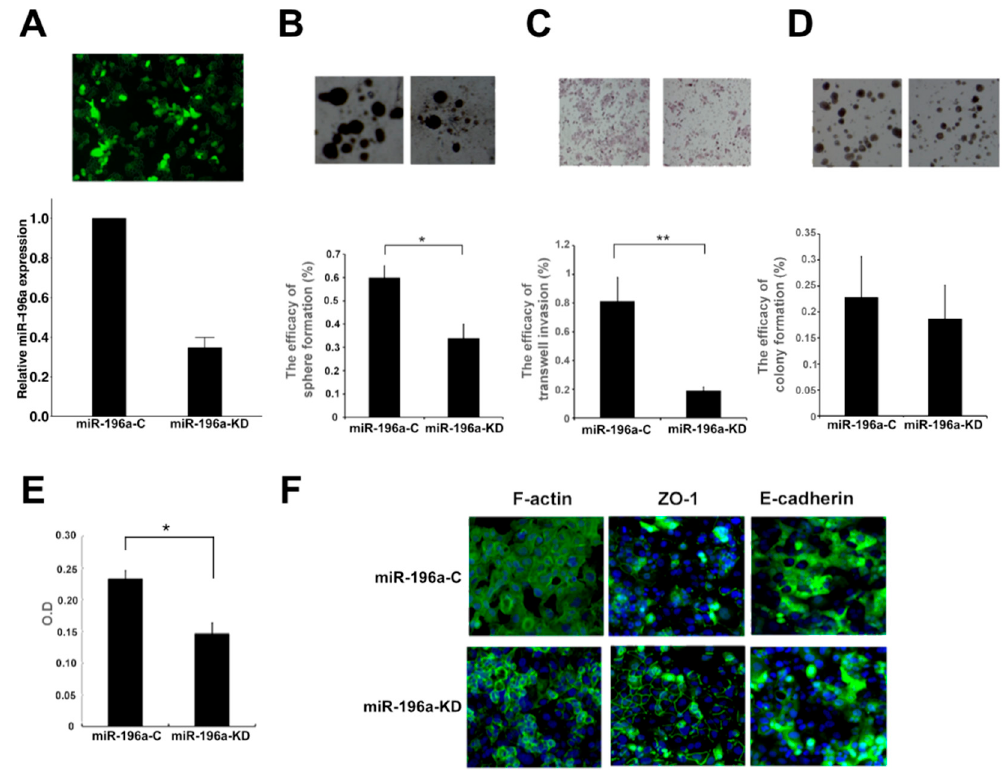
Figure 2. The effects of miR-196a knockdown on self-renewal, transwell-invasion, and colony formation of PLC cells. ( A ) Suppression knockdown (KD) of miR-196a after infection with lentiviral vectors expressing antisense miR-196a (miR-196a-KD) compared with that with negative control vectors (miR-196a-C). ( B–D ) Knockdown of miR-196a significantly decreased sphere formation of PLC cells ( B ) and transwell-invasion ( C ), but not colony formation ( D ). ( E ) Suppression of miR-196a decreased transendothelial migration capabilities of PLC. ( F ) miR-196a downregulation altered cytoskeleton organization, ZO-1 localization, but not E-cadherin. * p < 0.05, ** p < 0.01. Original magnification, ×100 ( A ), ×50 ( B ), ×100 ( C ), ×25 ( D ), ×400 ( F ).